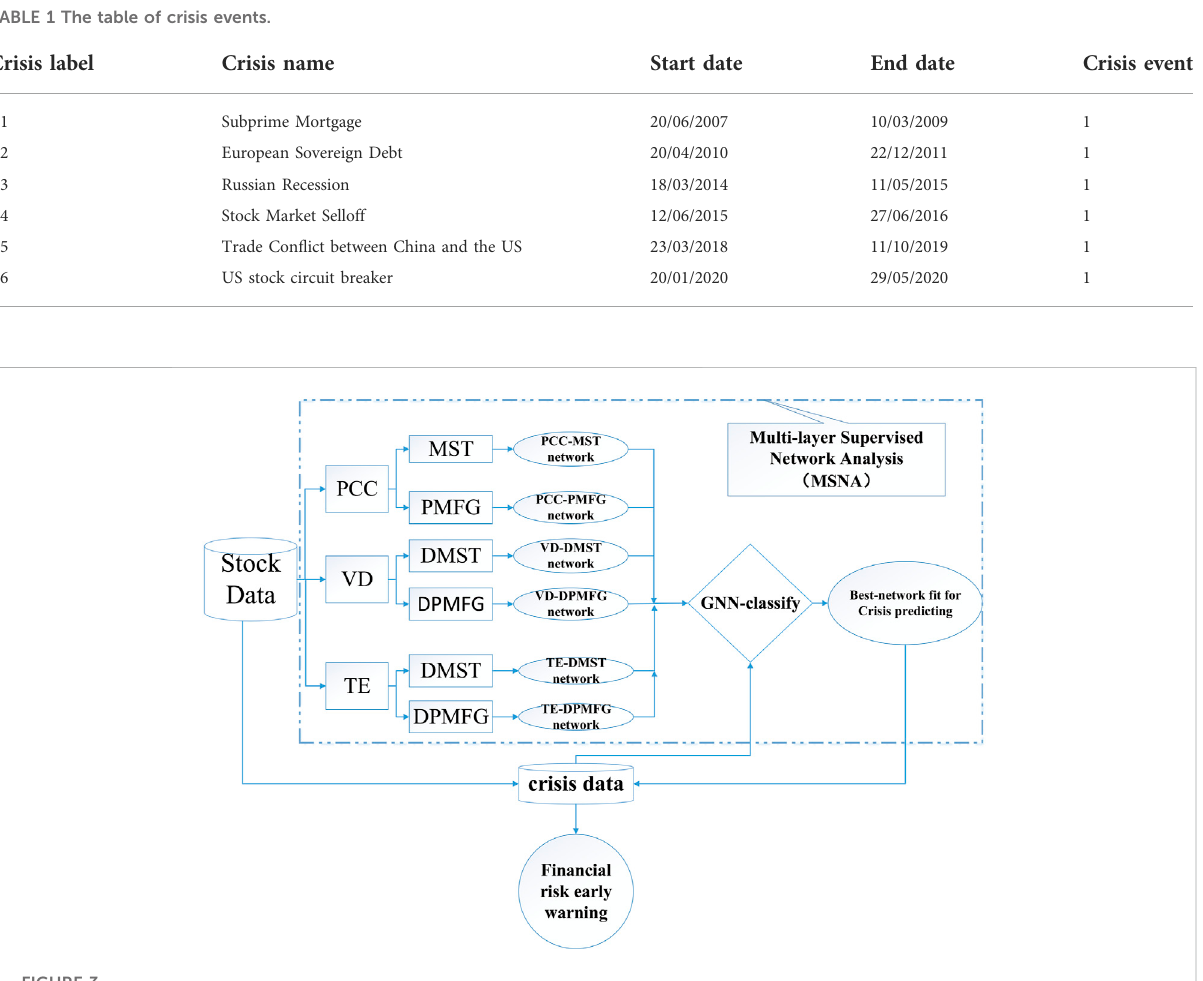
FIGURE 3 (Color online) Flow chart of the multilayer supervised